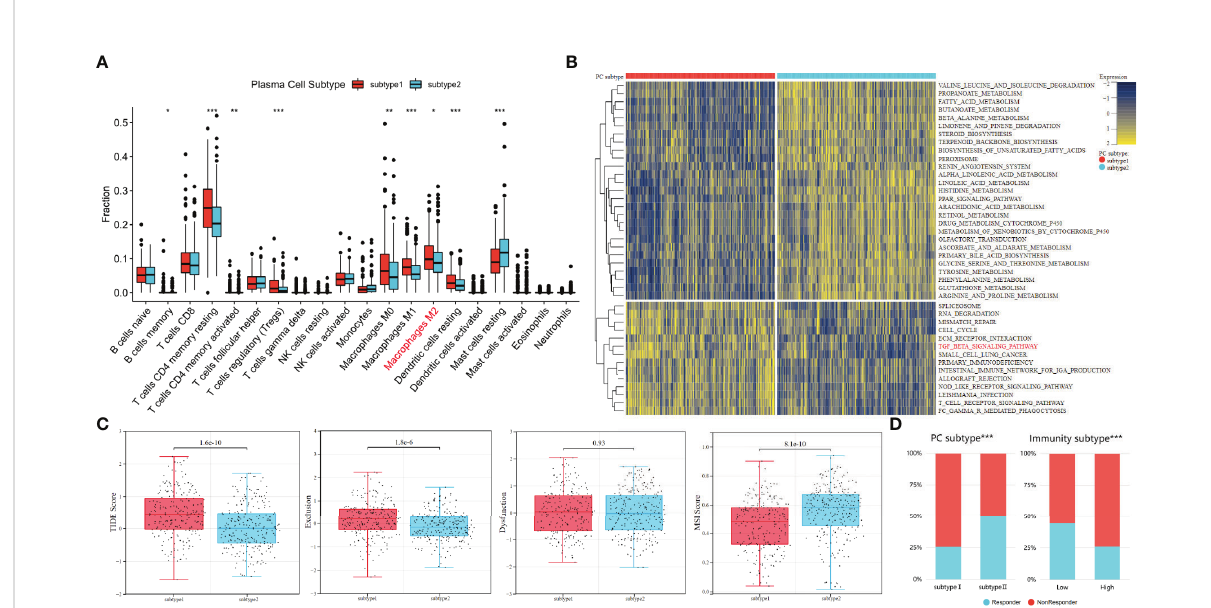
FIGURE 5 Analysis of immune escape potential and ef fi cacy of immunotherapy between plasma cell subtypes. (A) Comparisons of the fraction of 20 immune cells in two plasma cell subtypes. (B) Heatmap illustrated the enrichment scores of 41 differentially enriched molecular pathways evaluated by GSVA analysis between plasma cell subtype 1 and 2. Yellow and blue represented high and low enrichment scores, respectively. (C) TIDE, Exclusion, Dysfunction and MSI score different plasma cell subtypes. (D) Comparisons of the proportions of nonresponders and responder to immunotherapy among different classi fi cation methods. (Left: plasma cell subtype, Right: immune subtype). *P < 0.05, **P < 0.01, ***P <